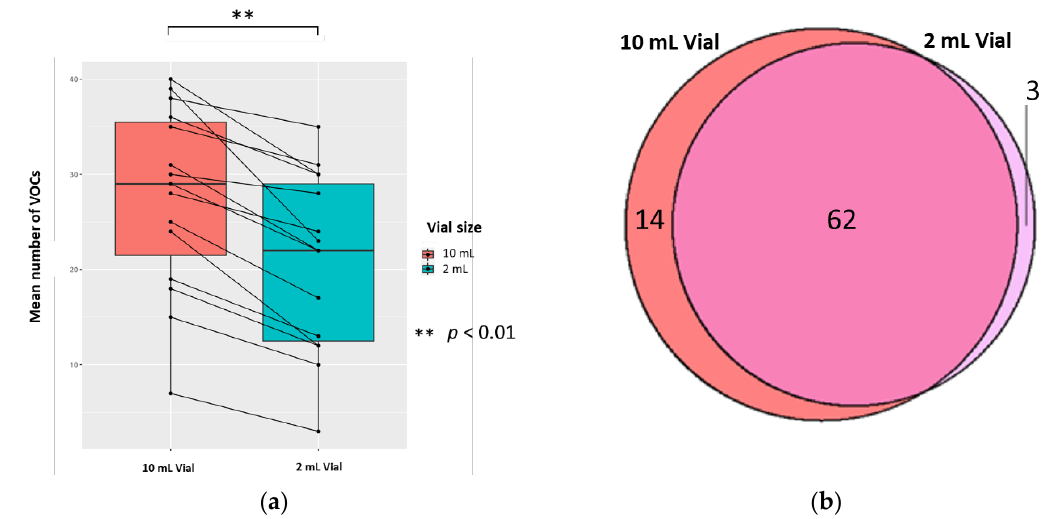
Figure 4. The urinary VOC profiles using 2 mL (red) and 10 mL (blue) vials ( n = 15). 0.5 mL urine was treated with 0.1 mL 5 M H 2 SO 4 , to yield 0.83 M final solution, pH 0.075. ( a ) Paired boxplot to show the cumulative unique number of VOCs produced per sample for either vial volume. ( b ) Venn diagram showing the unique VOCs detected in each vial volume.